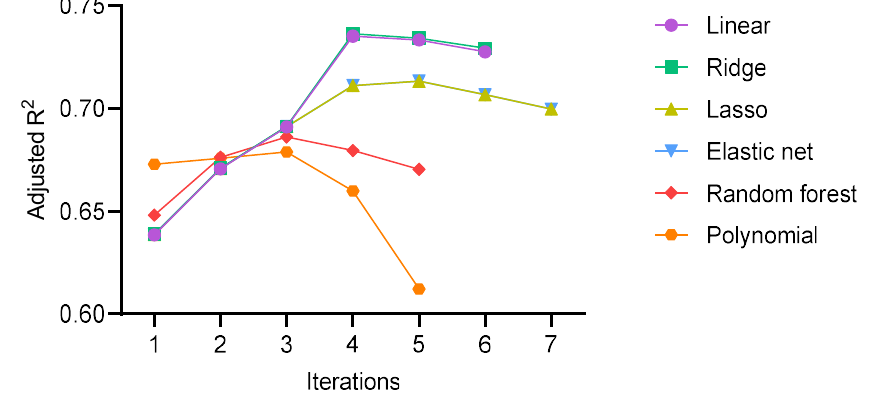
Figure 2. In each iteration, all of the remaining features in the matrix were traversed to obtain the best prediction result. The plot shows how the adjusted R 2 of the various models changed as features were iteratively added. Table 2. Feature selected by each model in each iteration.